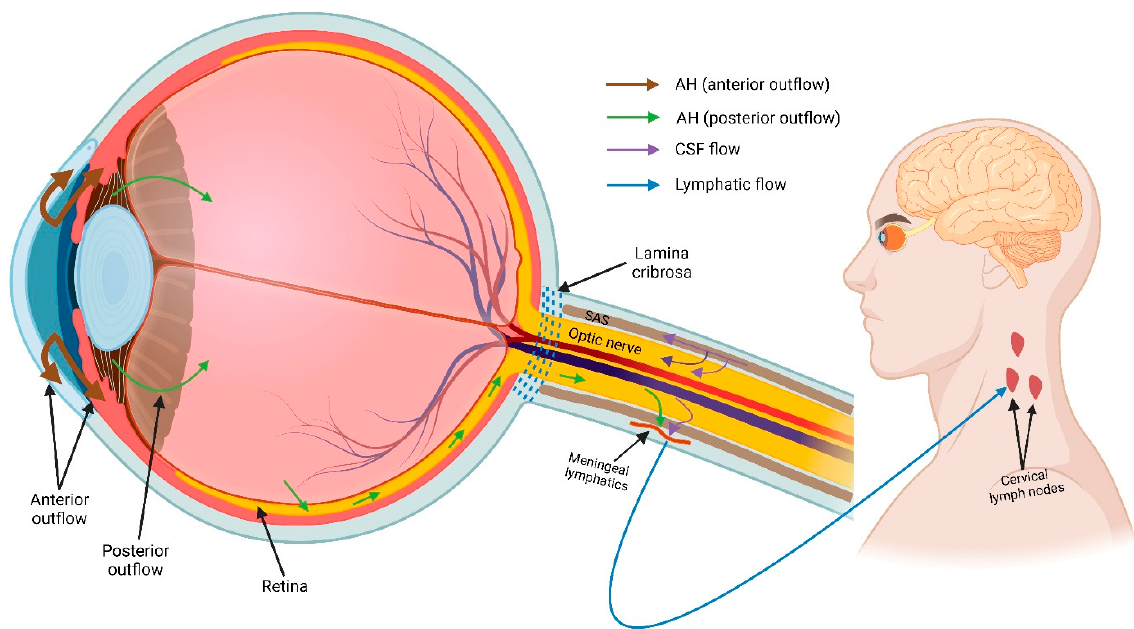
Figure 4. Ocular glymphatic system. Schematic showing the current understanding of the ocular glymphatic system. Following production, a major portion of AH leaves the eye via the anterior outflow pathway (brown arrows). A small portion of AH enters the vitreous chamber (green arrows), from where AH enters the neural retina due to intraocular pressure. In the retina, AH mixes with interstitial fluid and transport along retinal ganglion cell axons across the lamina cribrosa barrier. From there, AH leaves the axons, travel towards the perivenous space, and finally drains into cervical lymph nodes (blue arrow) via meningeal lymphatic vessels. Likewise, the optic nerve has a distinct glymphatic system. In this pathway, CSF from the sub-arachnoid space (SAS) enters the optic nerve parenchyma (purple arrows) along the periarterial space. Following glymphatic activity, CSF then leaves the optic nerve via perivenous space before draining into cervical lymph nodes via meningeal